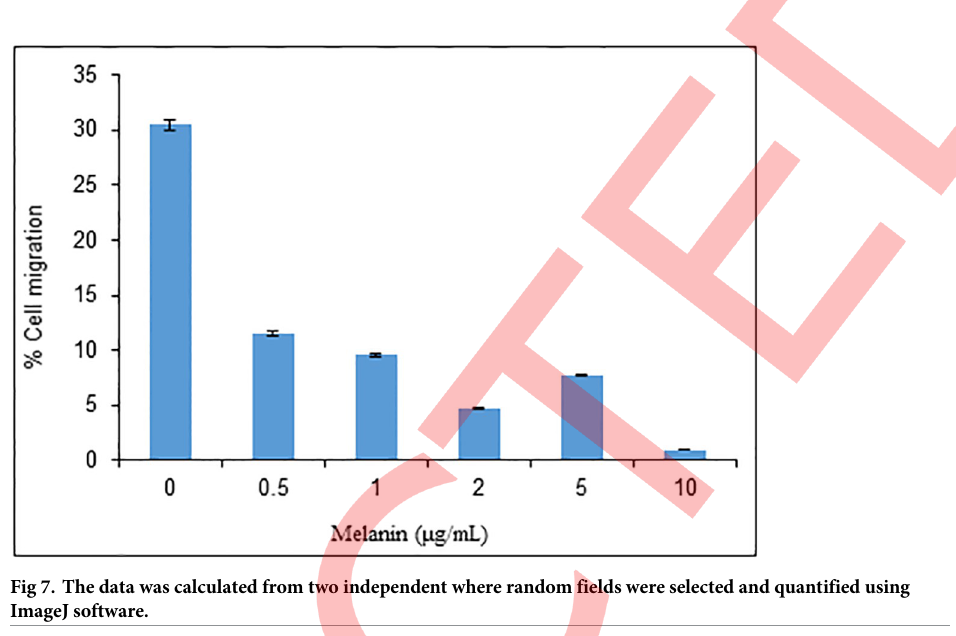
Fig 7. The data was calculated from two independent where random fields were selected and quantified using ImageJ